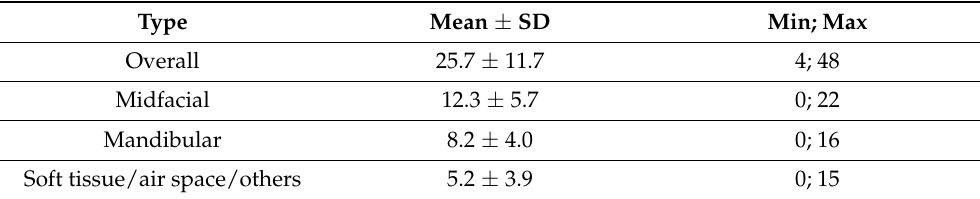
Table 4. Number of anatomical landmarks described by the 38